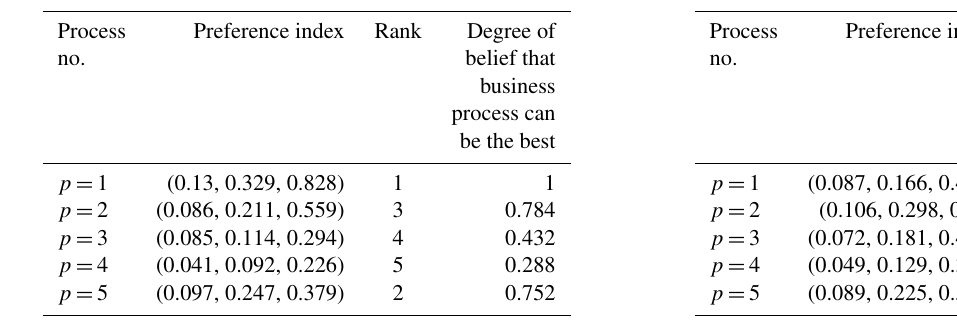
Table 4. Preference indices of business processes and their rank under quality performance.